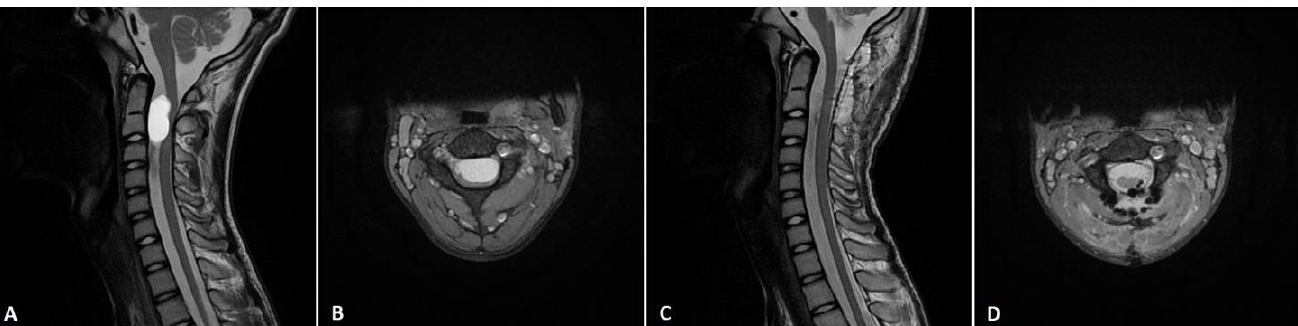
Figure 1. An exemplary case of a 14-year-old boy (patient no. 16), who presented with a left-sided motor deficit in the upper limb. Preoperative T2 ( A ) sagittal and ( B ) axial MRI scan showed C1-C2 intradural extramedullary tumor. The patient underwent gross-total tumor resection via the posterior approach with laminectomy. Postoperative T2 ( C ) sagittal and ( D ) axial MRI scan confirmed complete tumor removal. Postoperatively, patients ’ motor function improved.